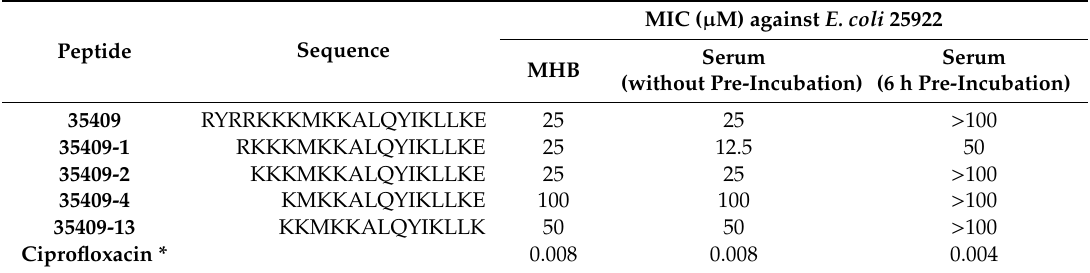
Table 4. Antibacterial activity of 35409-derived peptides in the presence of fresh human sera.